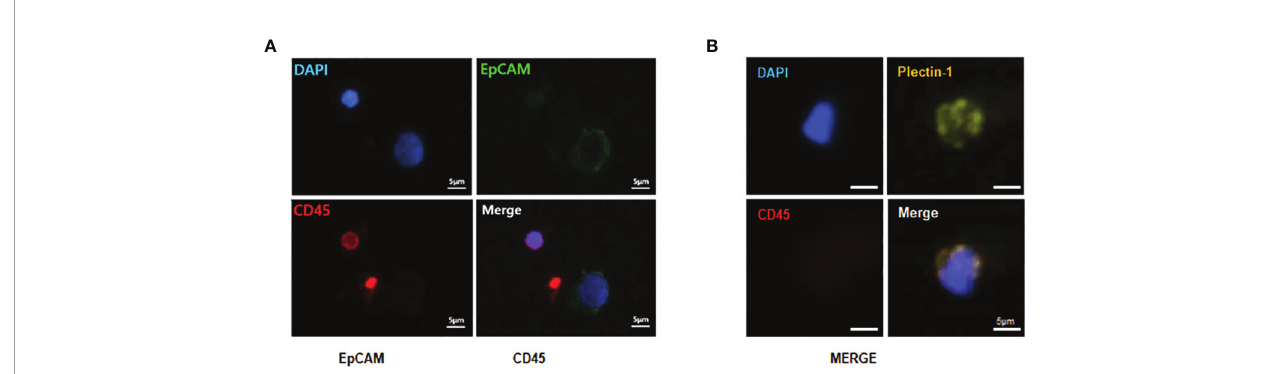
FIGURE 4 | Immuno fl uorescence staining of captured circulating tumor cells (CTCs) from patients with resectable pancreatic ductal adenocarcinomas (PDACs). To identify CTCs, captured CTCs from PDAC patients were immunostained with anti-epithelial cell adhesion molecule (EpCAM) (green), anti-Plectin-1 (gold) and anti- CD45 (red) antibodies. Nuclei were counterstained with DAPI (blue). CTCs are (A) EpCAM + or (B) Plectin-1 + among CD45 - DAPI + cells. Scale bar, 5 m m.